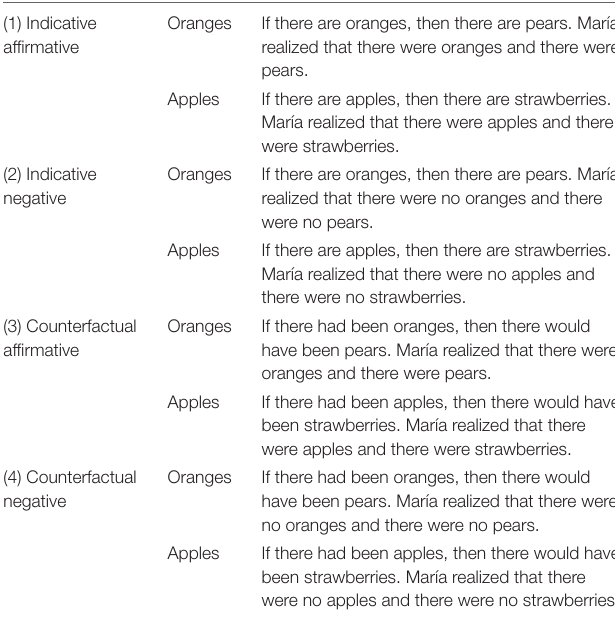
TABLE 1 | Examples of the 8 versions of the verbal description of each content, illustrated for the oranges and pears/apples and strawberries content, for the visual display in Figure 1